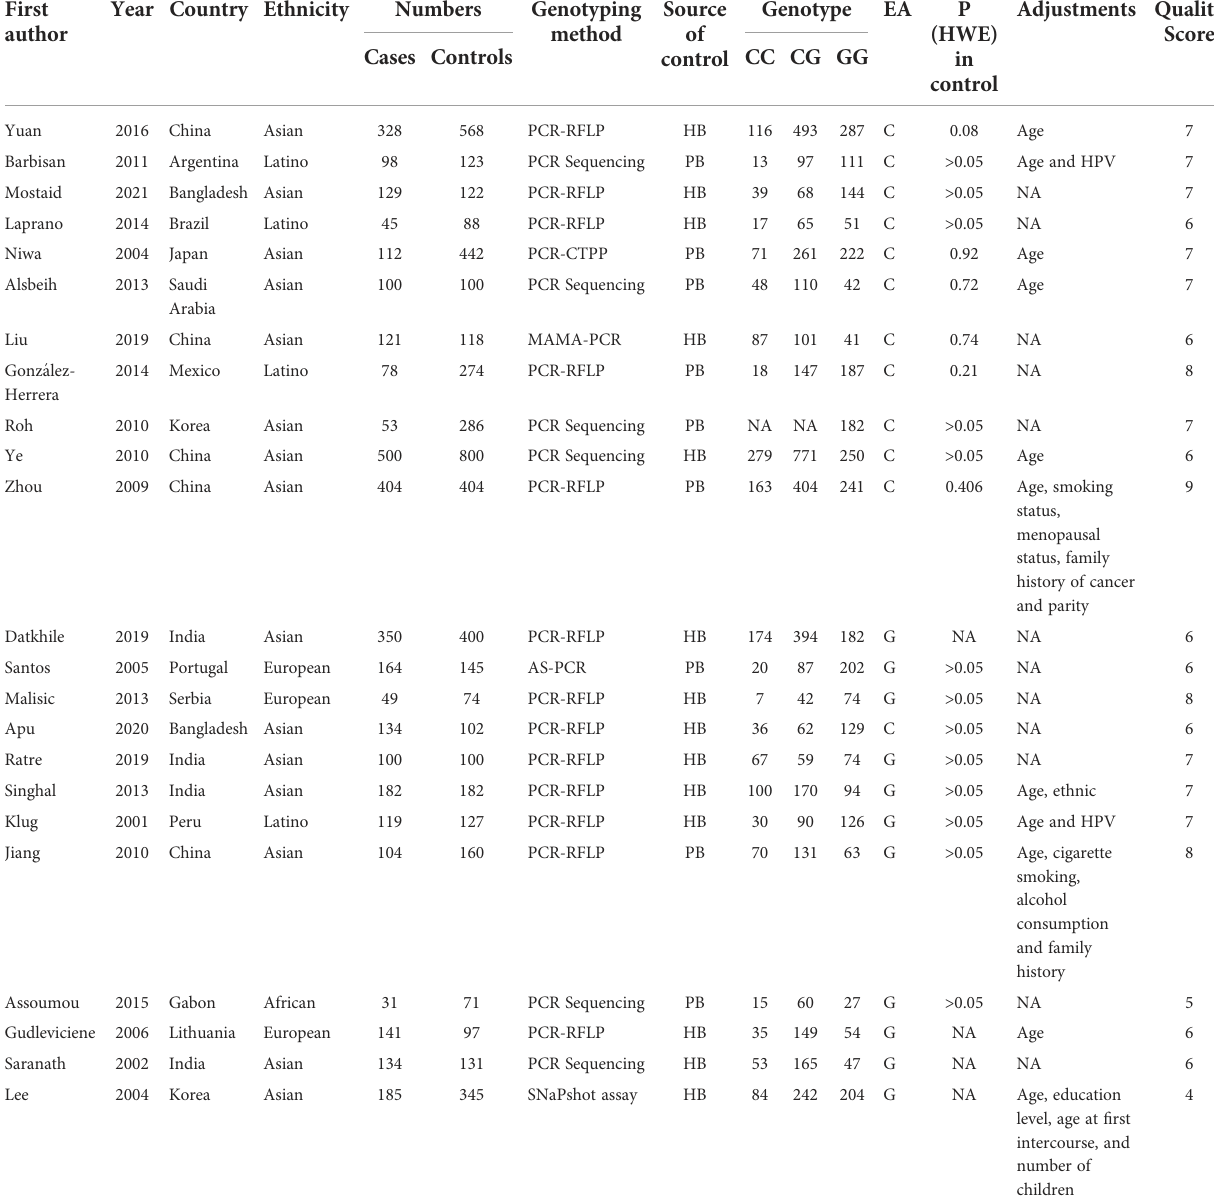
TABLE 2 Characteristics of the studies of TP53 rs1042522 polymorphism included in the